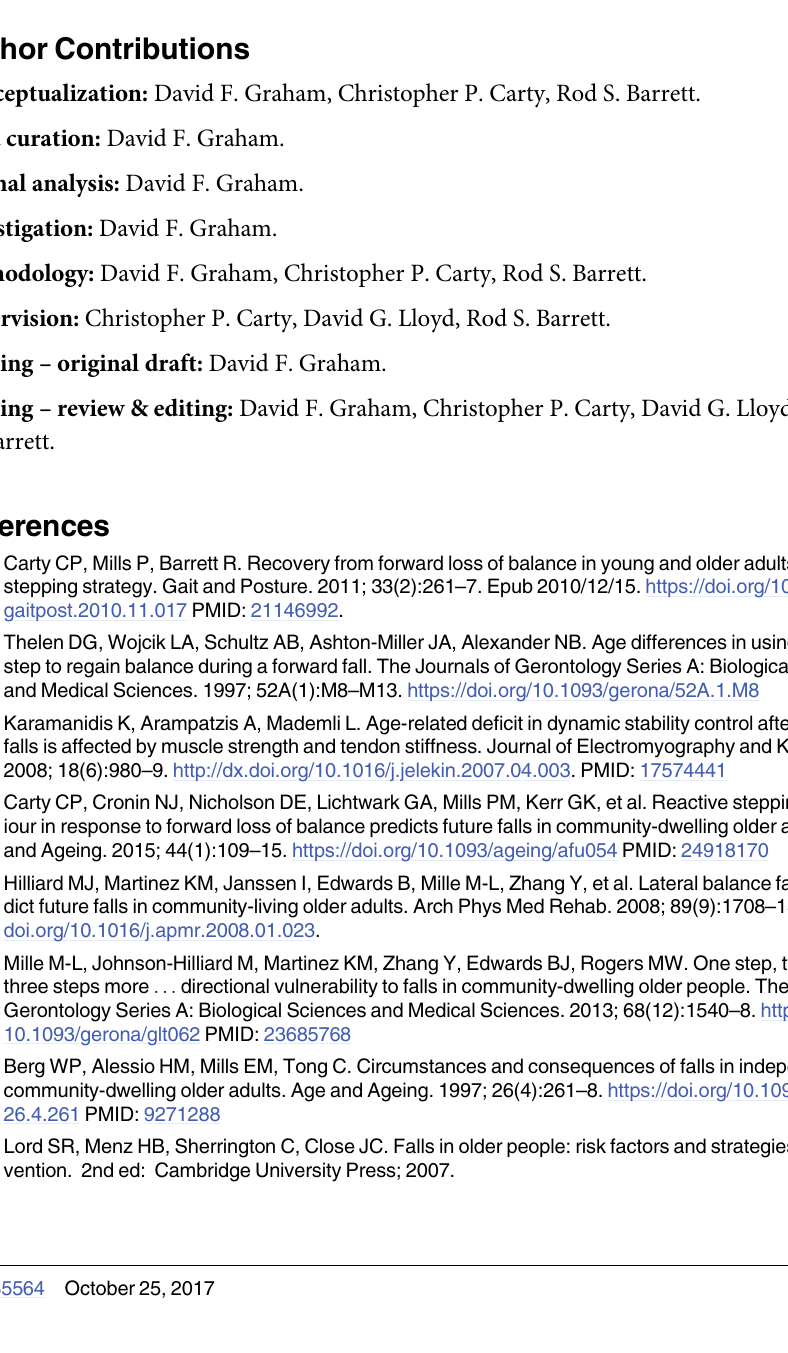
S1 Fig. Comparison of pelvic residual forces and moments derived from inverse dynamics (grey line) and the residual reduction algorithm (black line), plus reserve actuator moments from the lower limb of the stepping leg for a representative participant during balance recovery from cable release (CR) to knee joint maximum (KJM). (TIFF) S2 Fig. Comparison of joint angles derived experimetally from inverse kinematics (IK) and the residual reduction algorithm (RRA) for the lower limb of the stepping leg of a repre- sentative participant during balance recovery from cable release (CR) to knee joint maxi- mum (KJM).